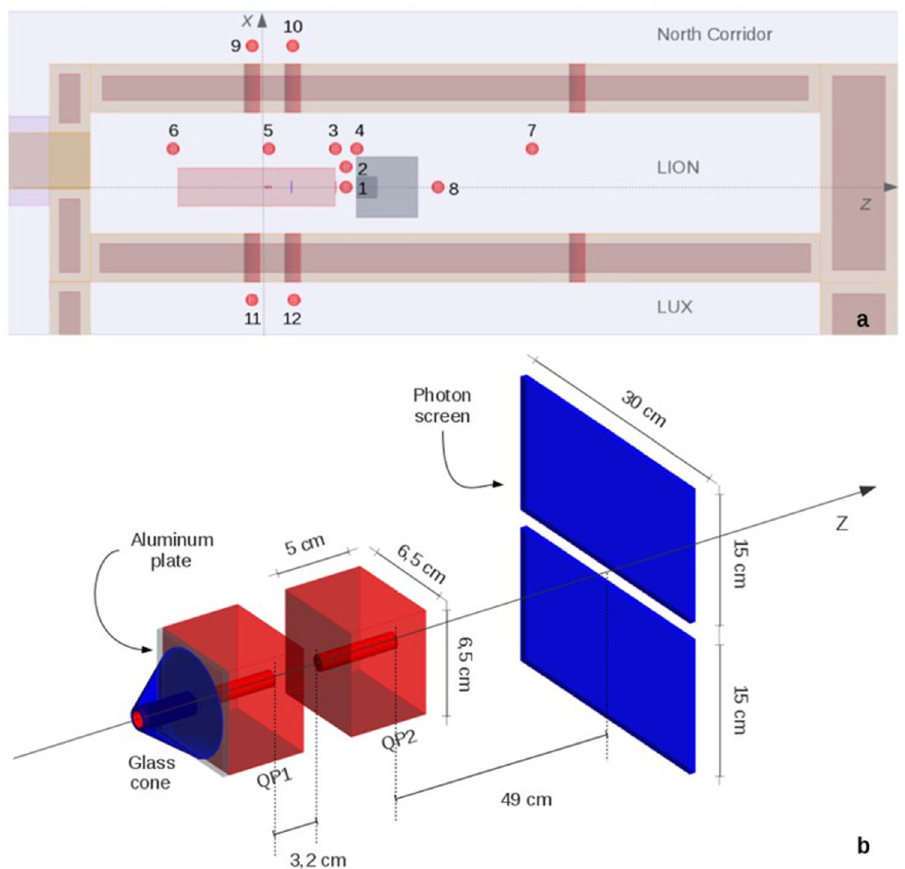
Figure 2. LION geometry as implemented in Geant4. ( a ) Top view of the facility and scorers (red) with ID number. ( b ) Close-up on the two quadrupole magnets (QPs), with protection layer and glass hollow cone mounted on the first QP and photon screen. Figures are not drawn to